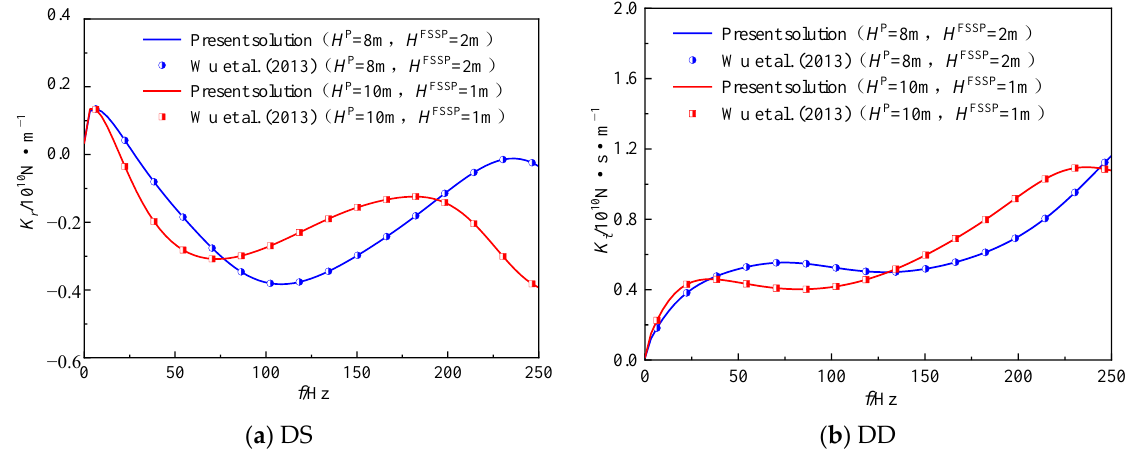
Figure 3. Comparison of the reduced form of DI with the DI derived by Wu et al. [15].